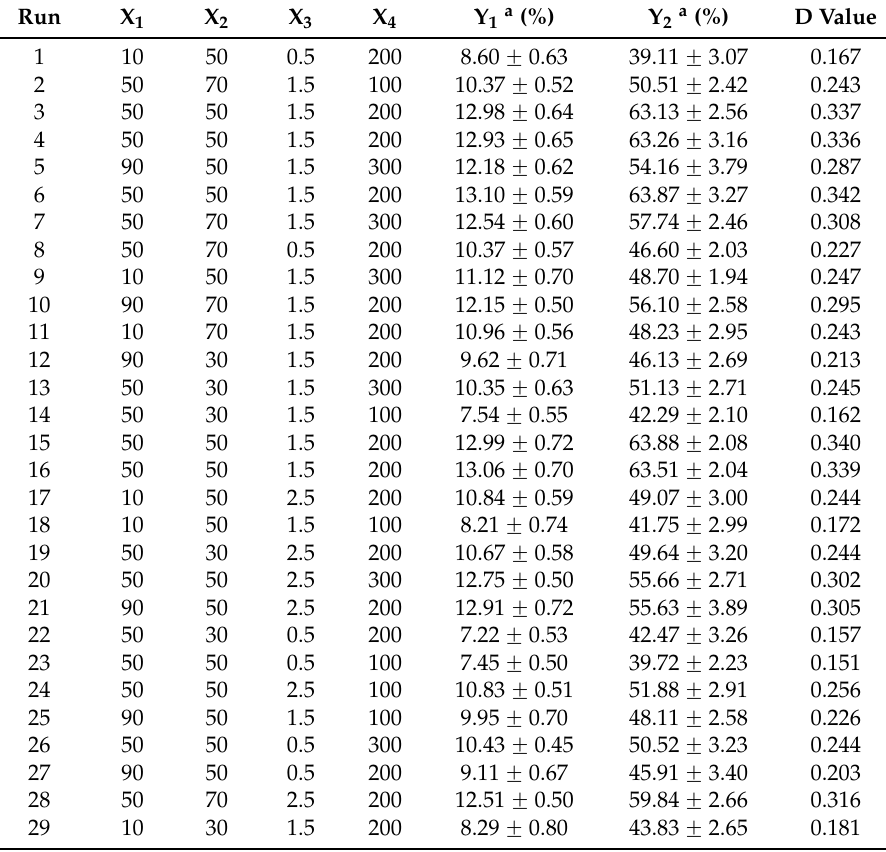
Table 1. BBD matrix and response values for extraction yield and DPPH scavenging percentage of RAMP as well as D